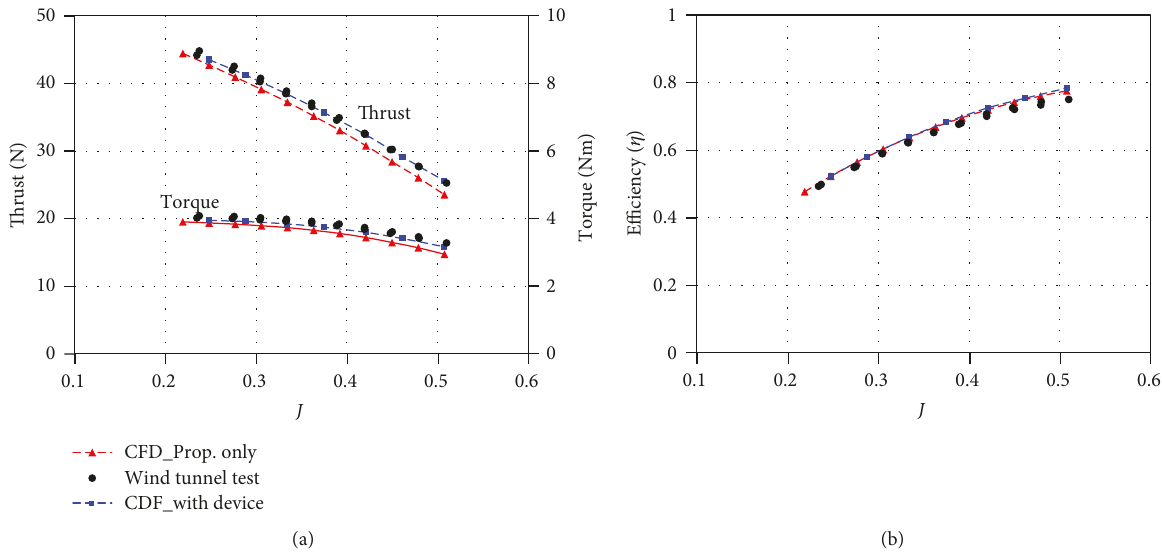
Figure 22: Comparison of CFD results with (a) design code and (b) wind tunnel test.